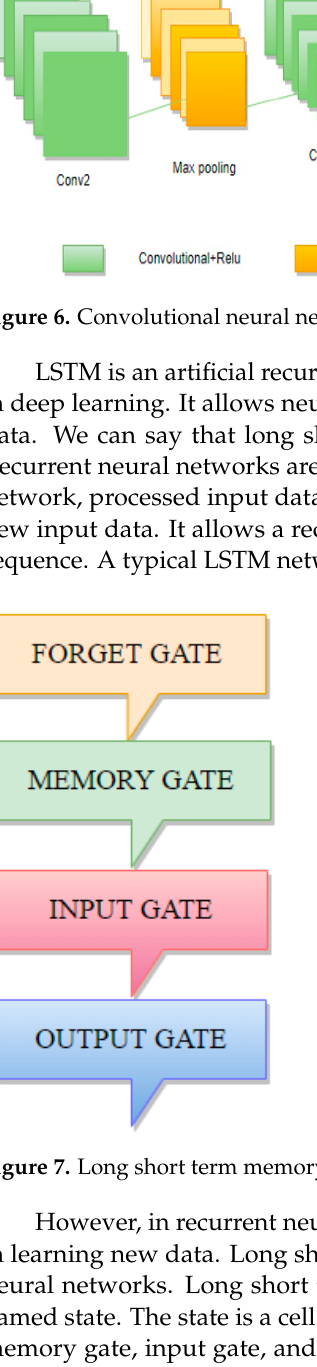
Figure 6. Convolutional neural networks.